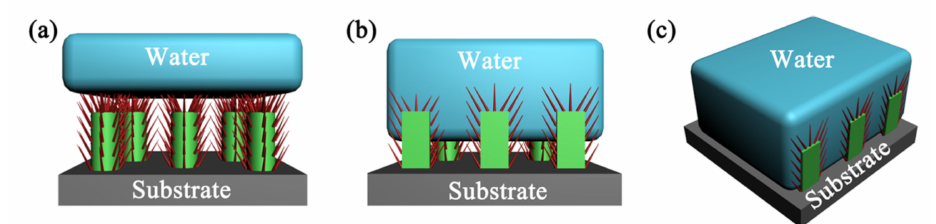
Figure 1. Three wetting behaviors: ( a ) Cassie–Baxter state (i.e., water only contacts with atop of hierarchical structures); ( b ) mixture state between Cassie–Baxter state and Wenzel state; and ( c ) Wenzel state (i.e., completely wetted state, cross-sectional